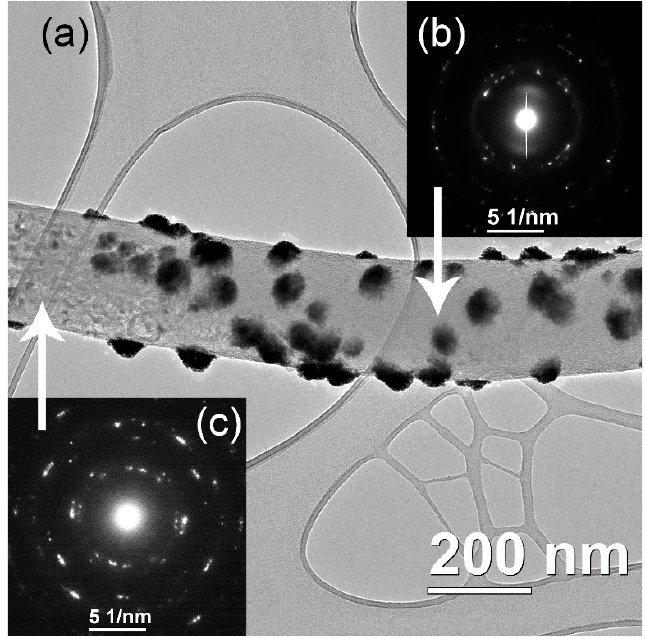
Figure 7. ( a ) BF TEM image of CNF (sample 4 ) with smooth and crystalline fragments; ( b ) SAED pattern taken from a smooth fragment; and ( c ) SAED pattern taken from a crystalline fragment.